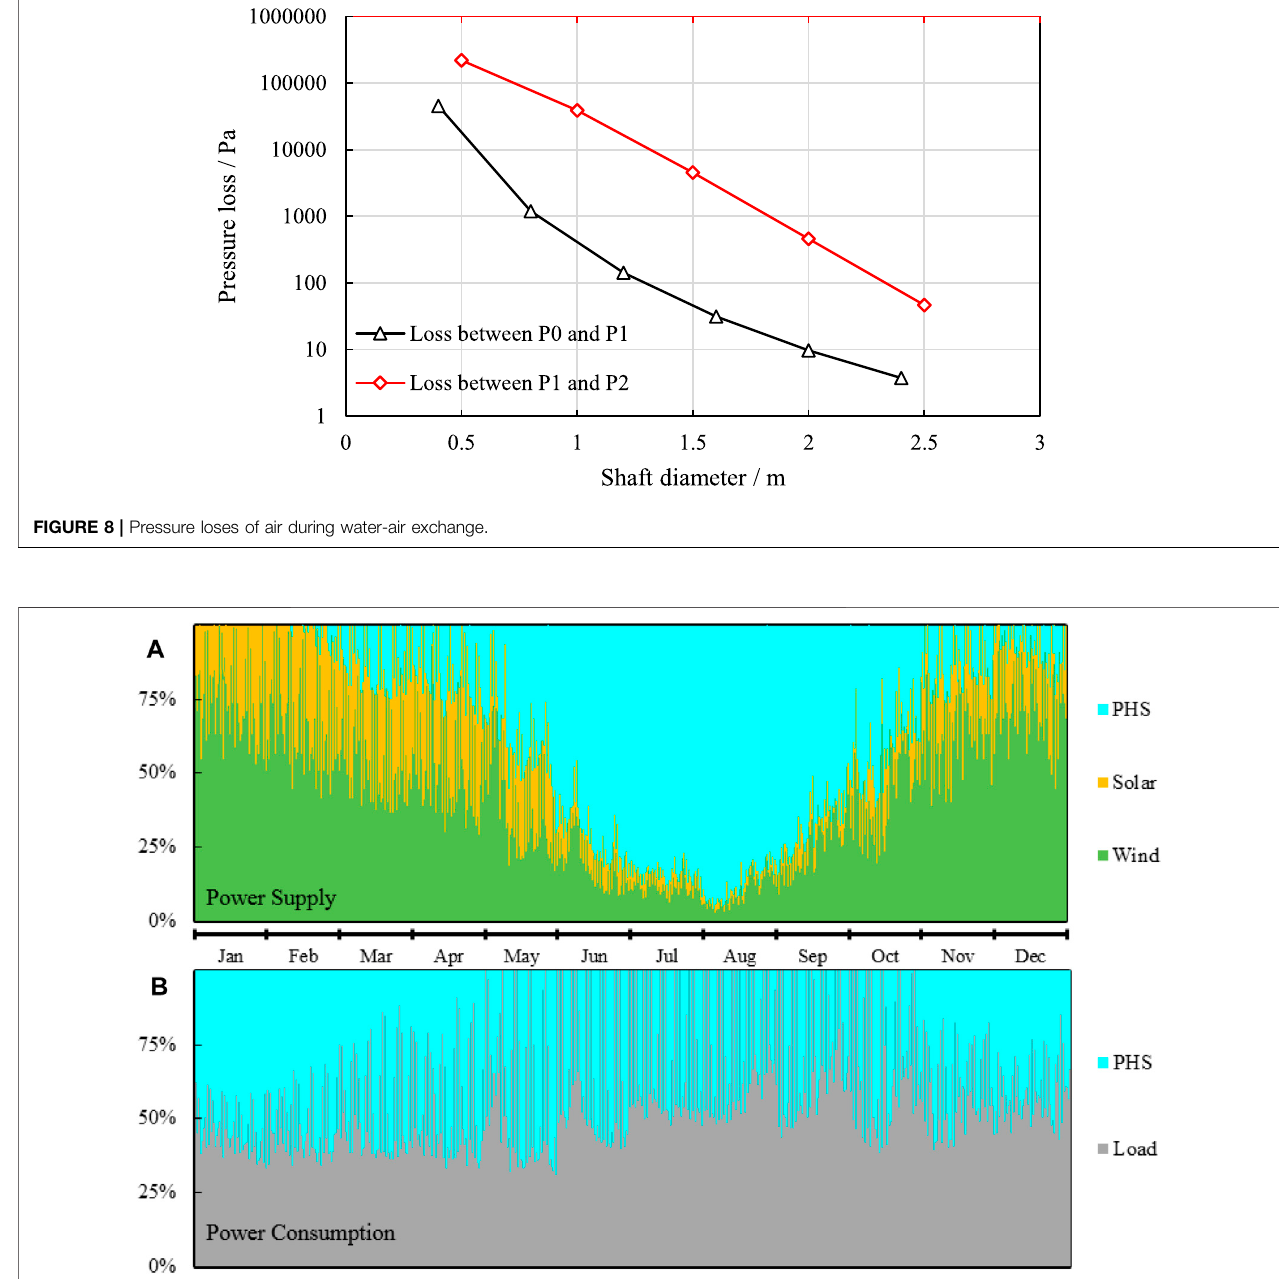
FIGURE 9 | Share of component supply and consumption of the goaf-PHS system over 8,760 h. (A) Share of component energy supply; (B) share of component energy consumption.